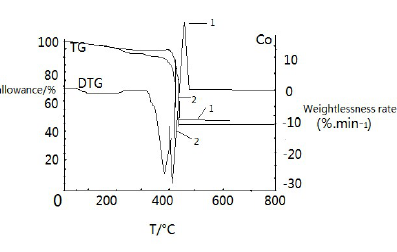
Figure 1. Derivative thermogravimetric curves.